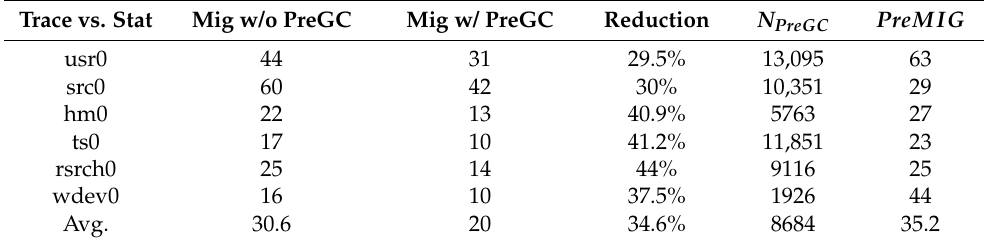
Table 4. Page migration